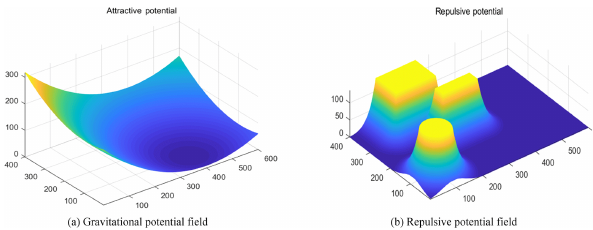
Figure 10. Potential field of the target point and obstacle point.